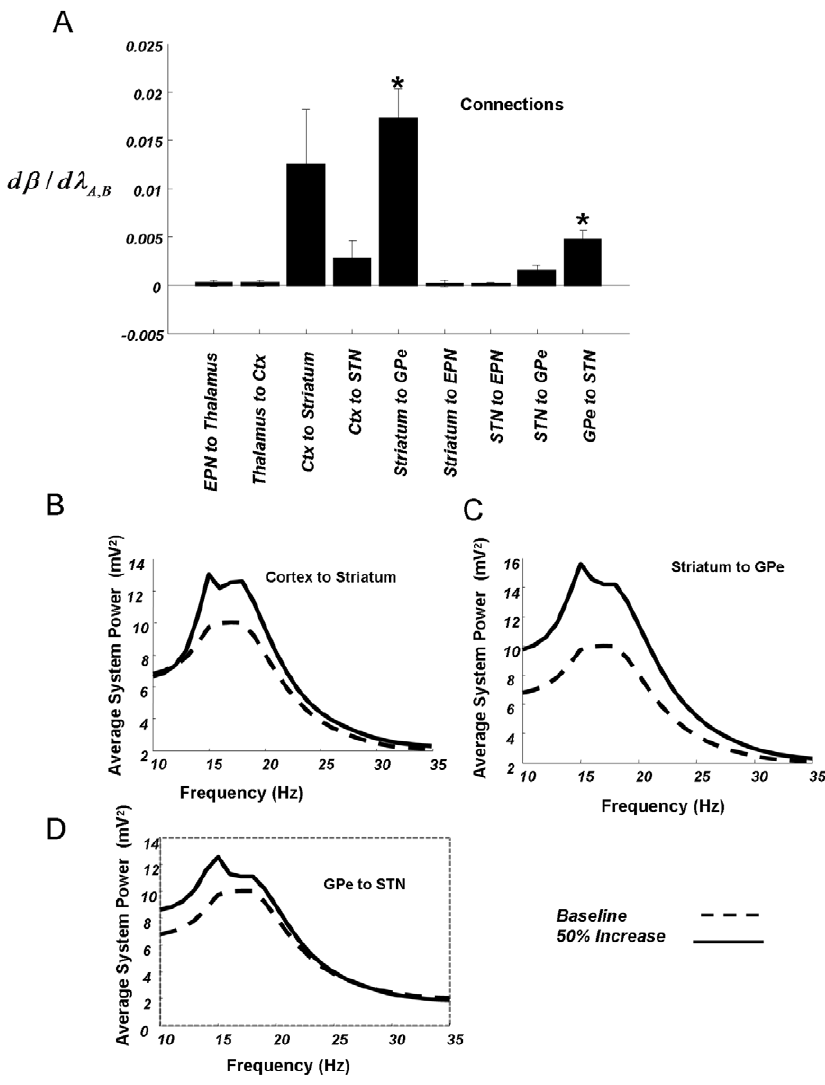
Figure 6. Contribution analysis. (A) Using the DCMs from the Parkinsonian animals, we quantified changes in beta power with respect to changes in connectivity parameters (averaged over channels). The measure of beta power was the height of the beta peak centred at 17 Hz (summed over 16–18 Hz). Increasing connections from striatum to GPe and from GPe to STN exacerbated beta oscillations (positive derivatives), where the striatum to GPe connectivity was the most effective (* p , 0.05 Bonferroni corrected for 9 multiple comparisons; Error bars denote s.e.m.). (B ) The average spectral response (over animals and circuit nodes) is plotted using baseline parameter values (dashed line) and an increase in cortex to striatum of 50% (solid line). (C) The same baseline transfer function, with altered transfer function following a 50% increase in connection strength from striatum to GPe. (D) Baseline and altered transfer functions following a 50% increase in GPe to STN (See also see Figures S4, S5 and S6 in Text S1).